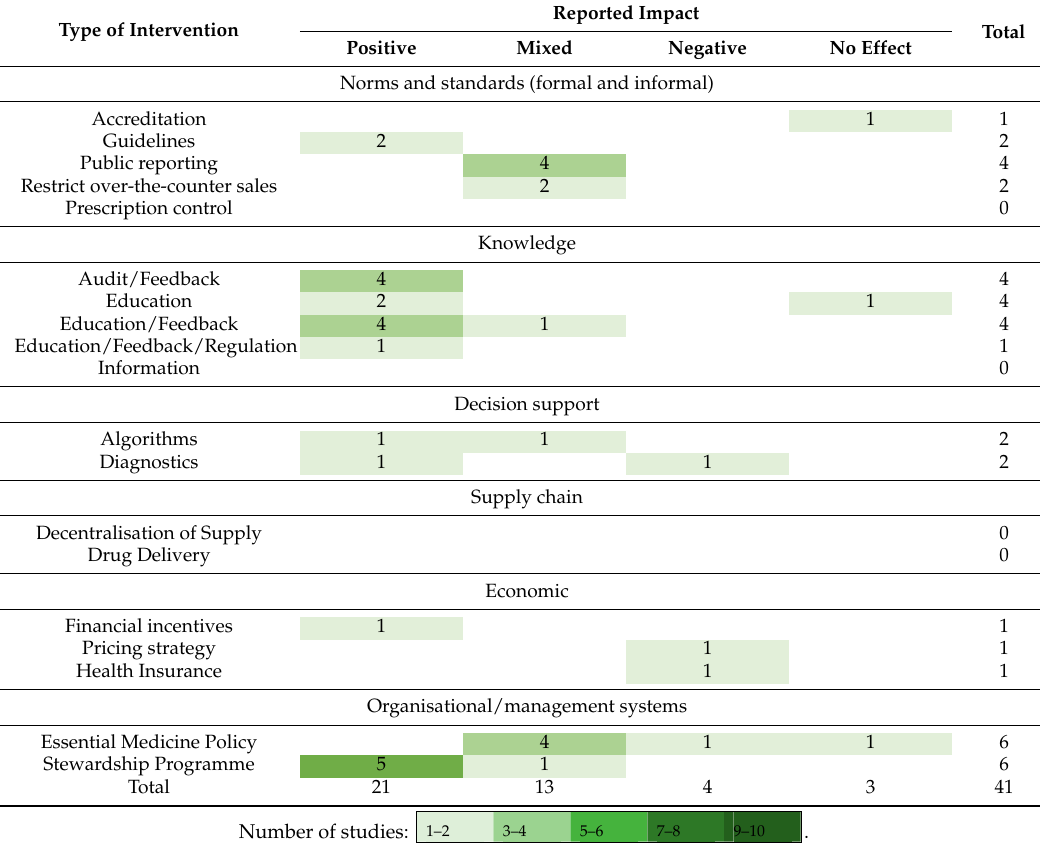
Table 5. Summary of intervention impacts